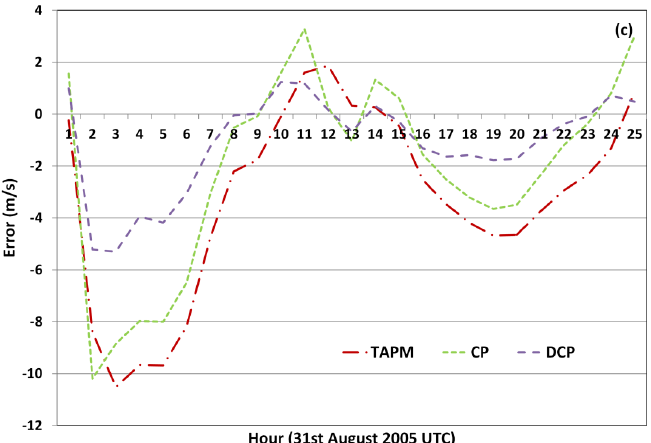
Figure 9. ( a ) Observations for the wind farm, TAPM predictions, and the CP and DCP forecasts with a 48 h bias window covering the period 25th–31st August 2005, illustrating various wind speed regimes experienced by the wind farm over a week—general day to day operation, highlighted by ↔ and an extreme wind event that occurs over the 31st August 2005. The main features of the extreme event are highlighted by #, and *; ( b ) zooming down into the extreme event in Figure 9a; ( c ) the magnitude error for each of the forecasts for the 24 h period covering the extreme event on the 31st August 2005.